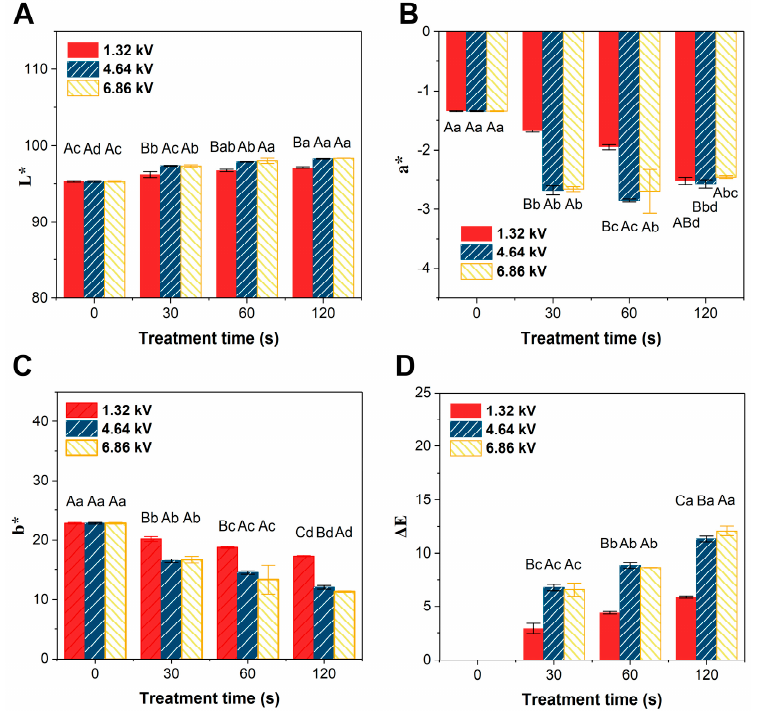
Figure 7. Effects of input power (1.32, 4.64, and 6.86 kV) and treatment time (0, 30, 60, and 120 s) on the color parameters of apple juice treated by cold plasma. ( A ) L* represents “brightness/darkness”, ( B ) a* represents “redness/greenness”, ( C ) b* represents “blueness/yellowness”, and ( D ) ∆ E represents the total color difference. The experiments were repeated three times in duplication, and the results are expressed as mean ± standard deviation (SD). For treatments with different input power (uppercase) and treatment time (lowercase), the means with different letters demonstrate a statistically significant difference ( p < 0.05) between them.